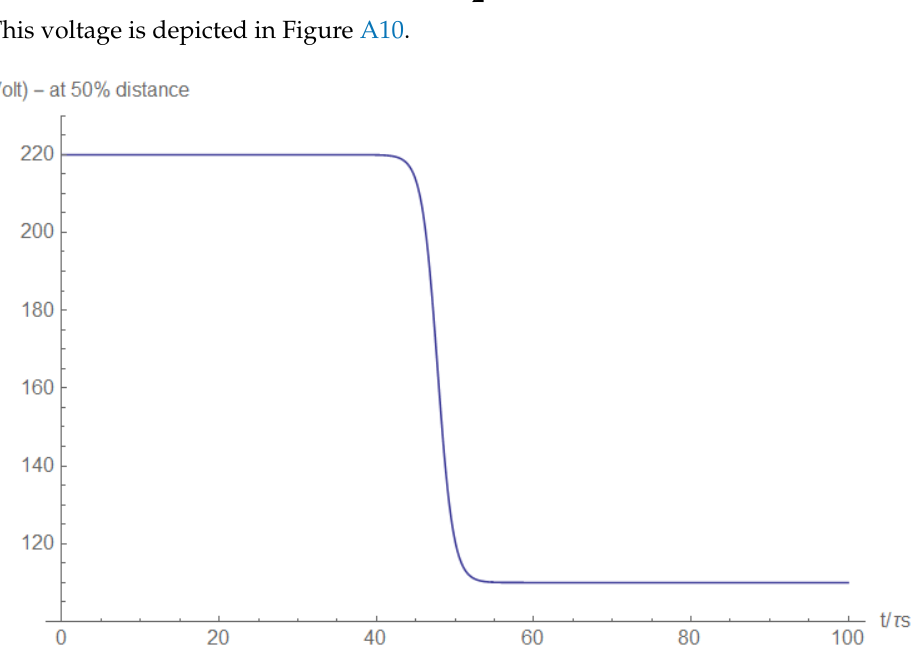
Figure A10. Voltage at half the distance between the source and the